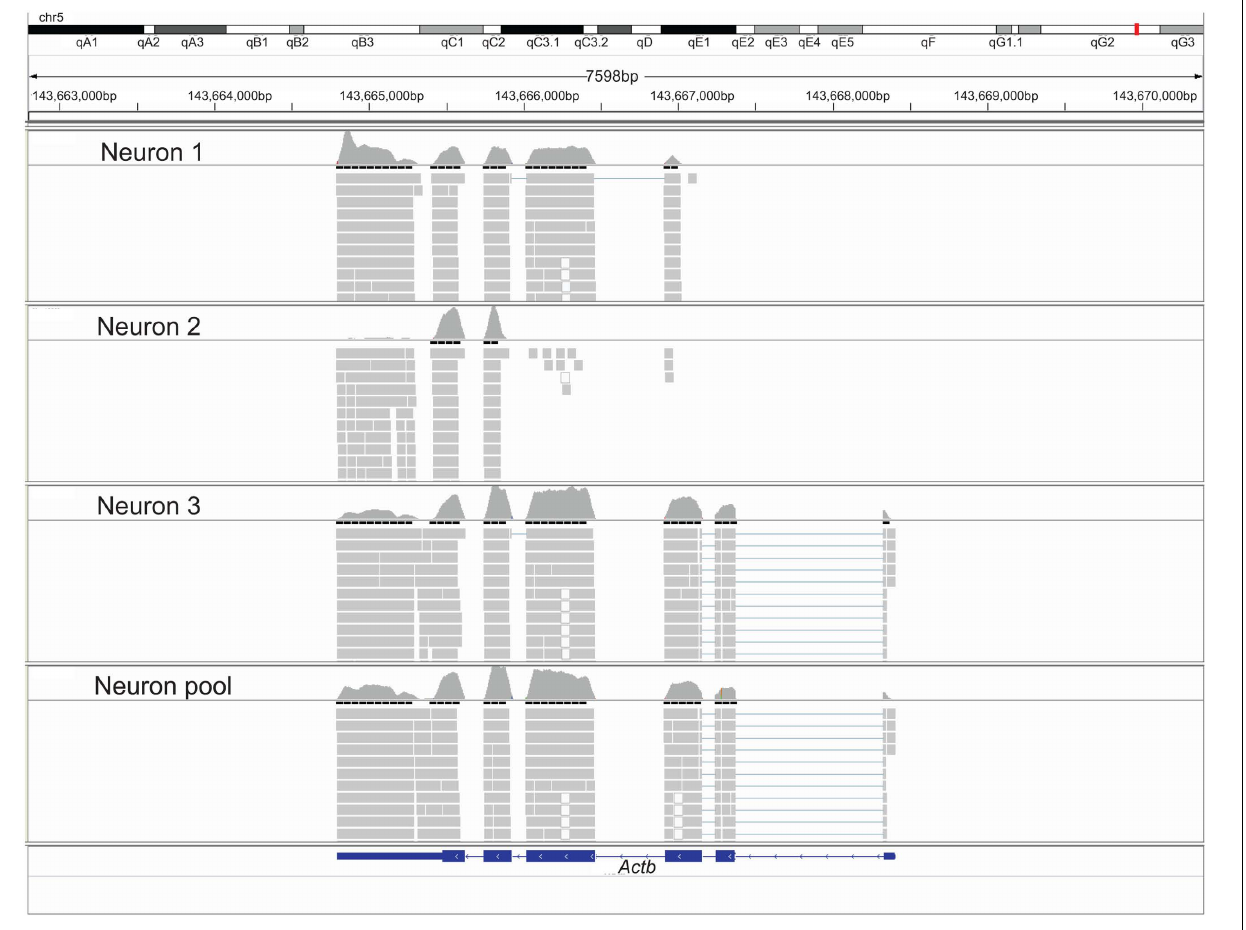
FIGURE 4 |A Integrative GenomicsViewer screen shot of the Actb locus, showing the coverage levels and alignments locations for three single live neurons and the 4-neuron pool from the same brain slice.